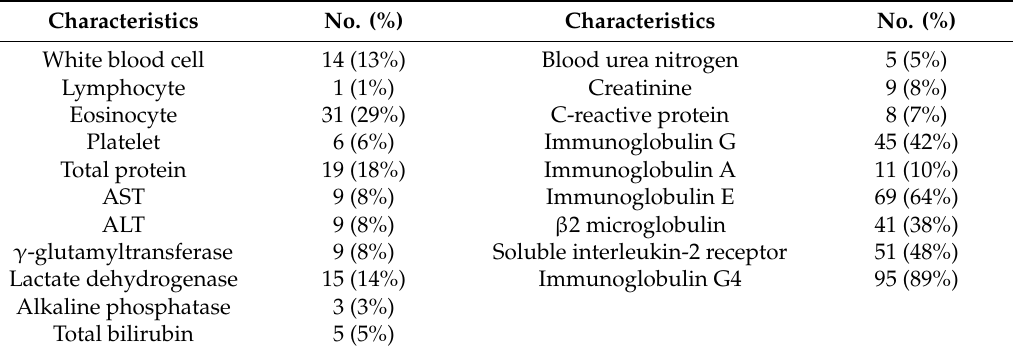
Table 2. Number of patients who have an abnormal value in the peripheral blood test.